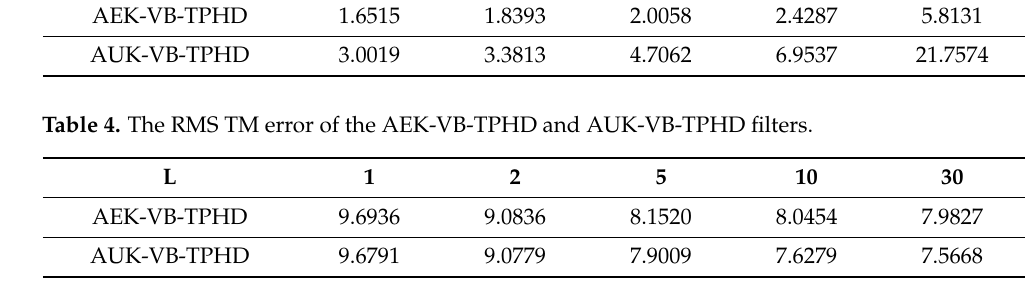
under RMS TM metric under time-varying noise measurement ( L = 5).